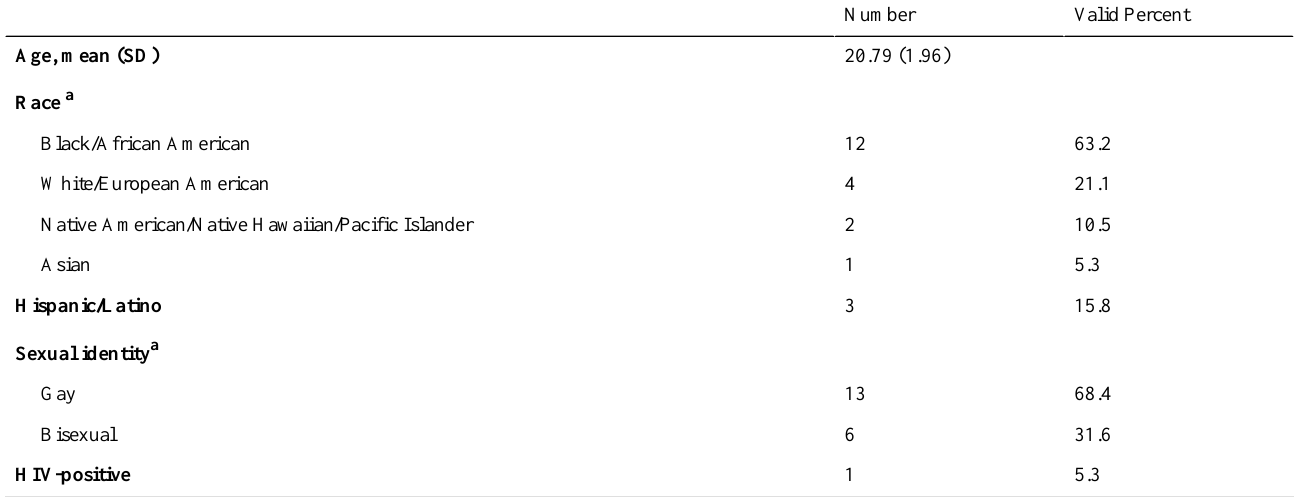
Table 3. Interview participant demographics (n=19).